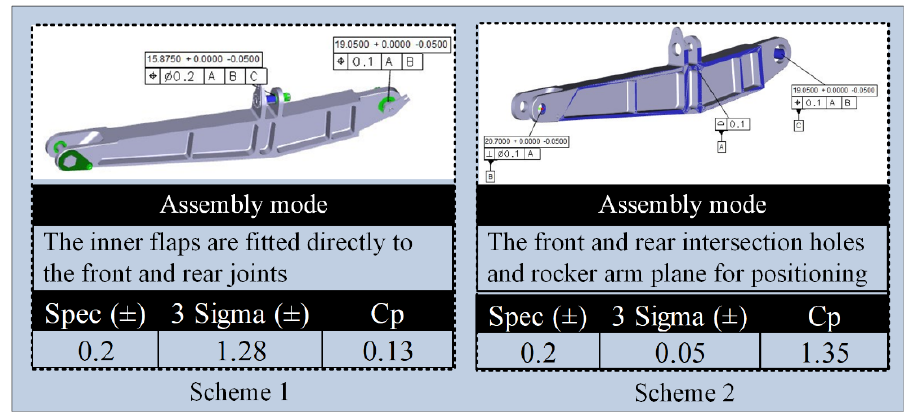
Figure 10. Schemes